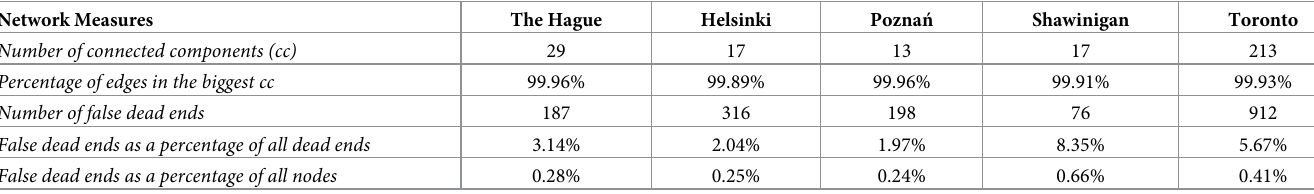
Table 3. Statistics related to